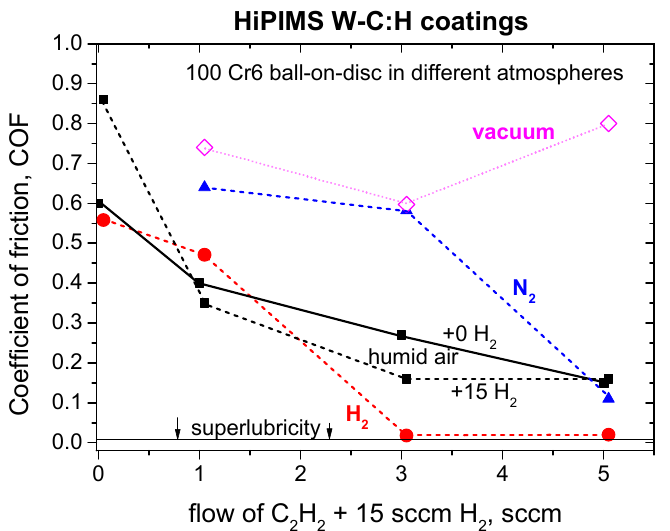
Figure 16. Effect of different atmospheres on the coefficient of friction in the W-C:H coatings deposited with variable amounts of C 2 H 2 + 15 sccm H 2 . The dependence for the coating deposited without hydrogen (full line with + 0 H 2 marking) was added for comparison.